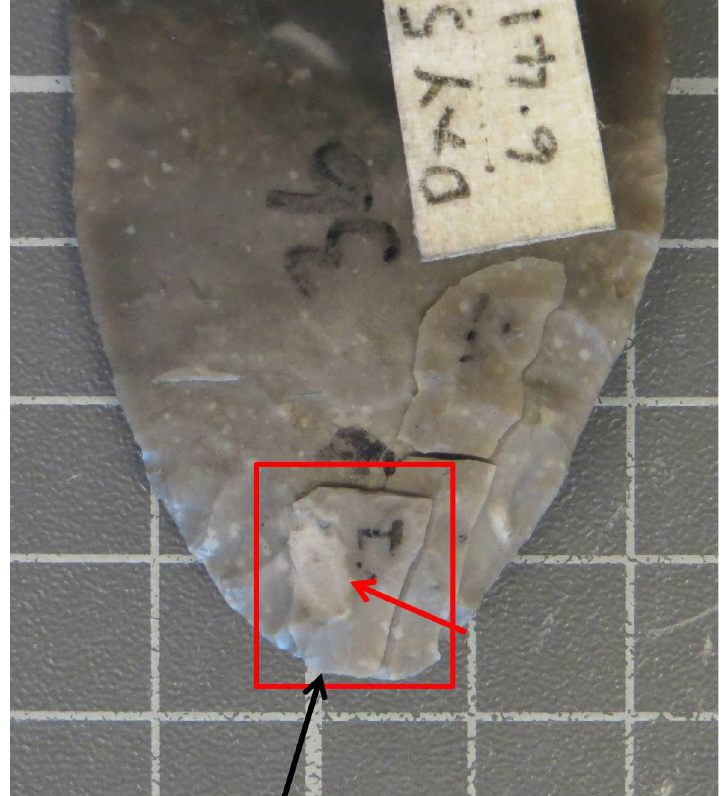
Figure 14. Blade-point 5.19, flake v1 with the black arrow indicating direction of removal blow and the red arrow dorsal scarring direction (photograph by the author). Gridlines on this image are 10mm